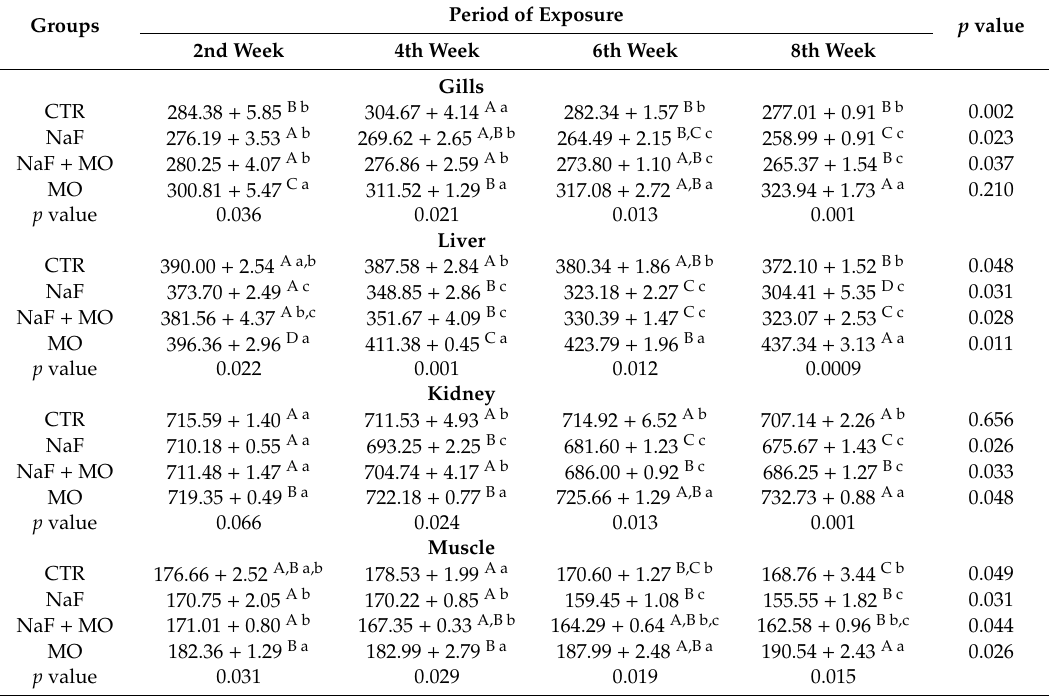
Di ff erent superscript small letters within the same column indicate significantly di ff erent mean values between di ff erent groups. Di ff erent superscript capital letters within the same row indicate significantly di ff erent mean values between di ff erent periods of exposure. CTR, control; NaF, sodium fluoride (6.1 mg / L.); NaF + MO, sodium fluoride (6.1 mg / L) + Moringa oleifera extract (1% in ration); MO, M. oleifera extract (1% in